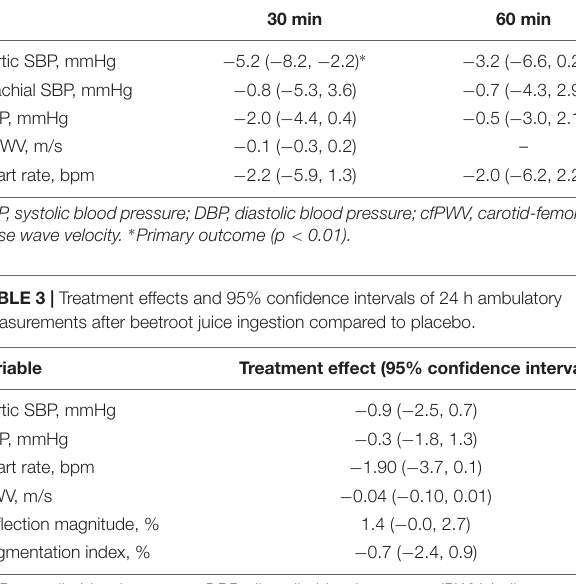
TABLE 2 | Treatment effects and 95% confidence intervals of clinic measurements 30 and 60 min post-ingestion of beetroot juice compared to placebo. Variable